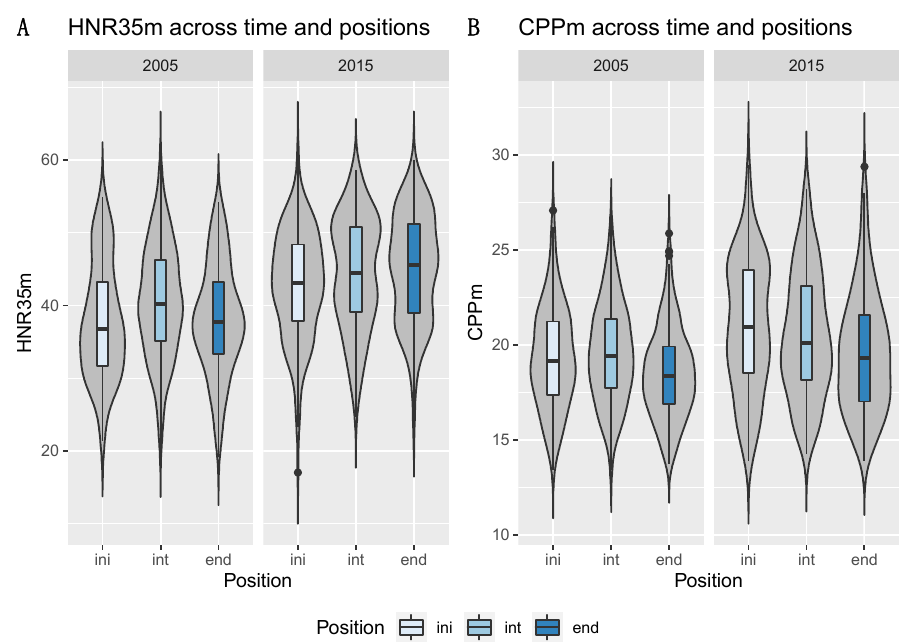
Figure 3. Violin plots showing rotated kernel density and boxplots with median values (black horizontal line) for noise measures (( A ): HNR35, ( B ): CPP). Data are split by TIME of recording (2005 and 2015) and POSITION (initial, internal, end) of the filler particle.